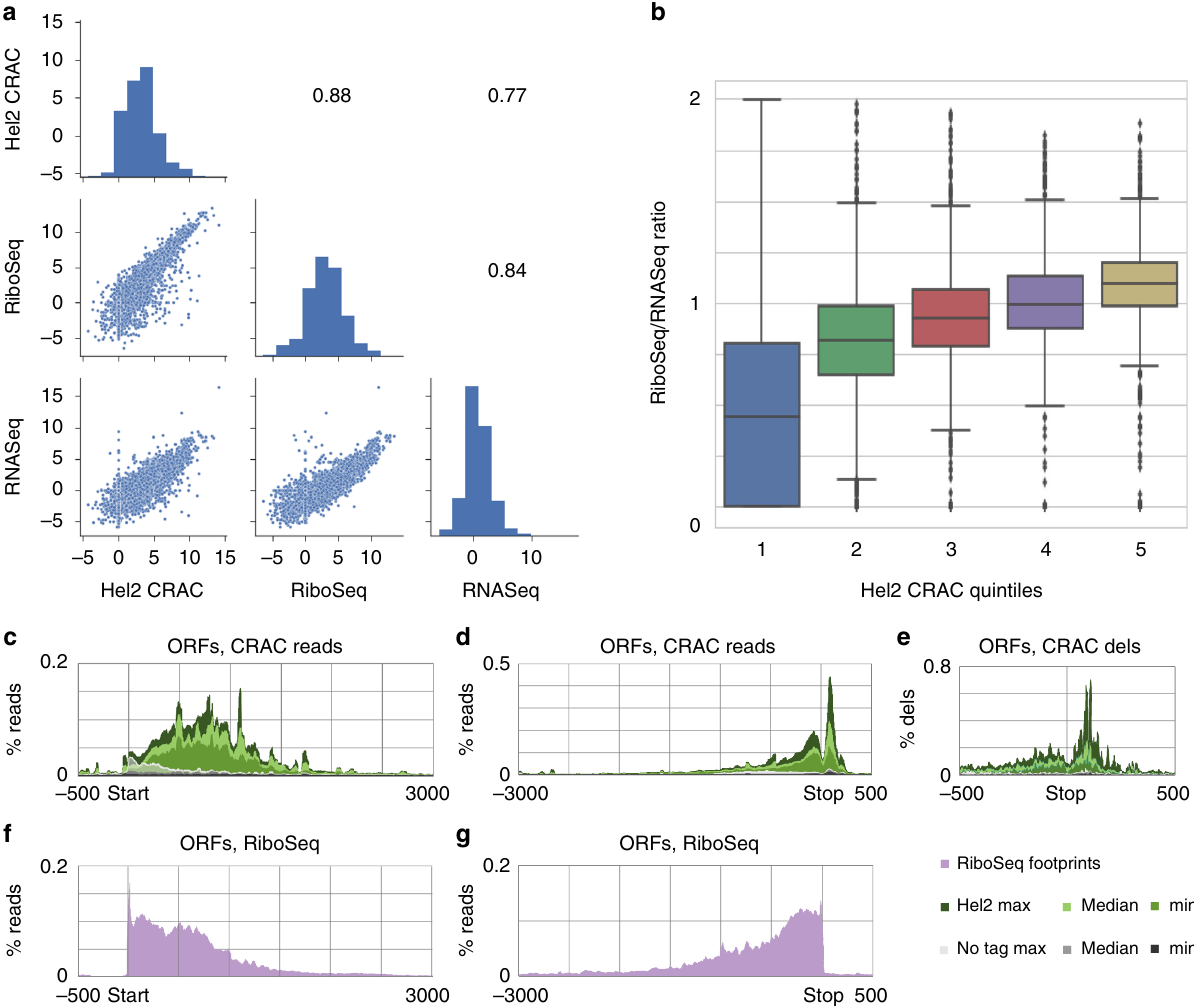
Fig. 8 mRNA binding by Hel2. a Abundance of protein-coding genes in Hel2 crosslinking and analysis of cDNA (CRAC) data sets (median of 6 data sets for each gene) compared to RiboSeq (1 data set; from ref. 43 ) and RNASeq (median of 3 data sets; from ref. 42 ). The latter two were from isogenic wild-type strains. All axes are in log2. Spearman correlation between abundances of protein-coding genes in RNASeq, Hel2 CRAC and RiboSeq (medians) is shown in the right panels. b Genes were grouped into quintiles according to Hel2 CRAC read counts, in hits per million per kilobase. These are plotted against the ratio of RiboSeq reads and RNASeq reads for each gene in the quintiles. Centre lines of box plots show the medians; box limits indicate the 25th and 75th percentiles; whiskers extend 1.5 times the interquartile range from the 25th and 75th percentiles, data points are plotted for outliers. c – e Metagene analysis of collapsed data sets performed for the subset of top 275 reproducibly Hel2-bound protein-coding genes with mRNA length of ≥ 500 nt. c , d Total reads mapped across open reading frames (ORFs) aligned by the translation start or stop codons. e Micro-deletions mapped across stop codons (smoothed data shown here, unsmoothed data shown in Supplementary Fig. 13). f , g RiboSeq footprints mapped across ORFs aligned by the translation start or stop codons. The values for “ % reads ” or “ % deletions ” shown are normalized to the sum of total Hel2 and no tag CRAC signal ( c – e ) or to the sum of all